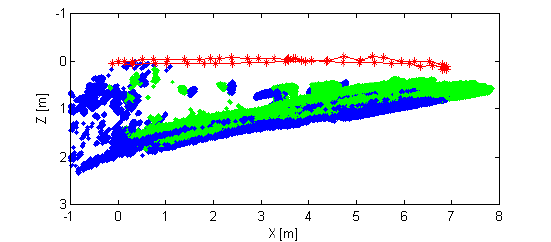
Figure 5: Projection of the estimated trajectory and thinned point cloud data onto the XZ -plane.